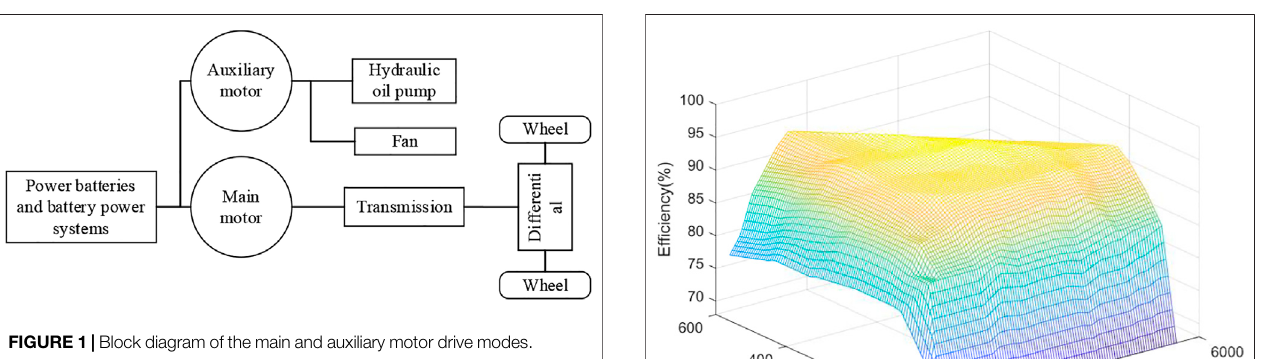
torque. The ef fi ciency map of the driving motor is shown in Figure 3 .